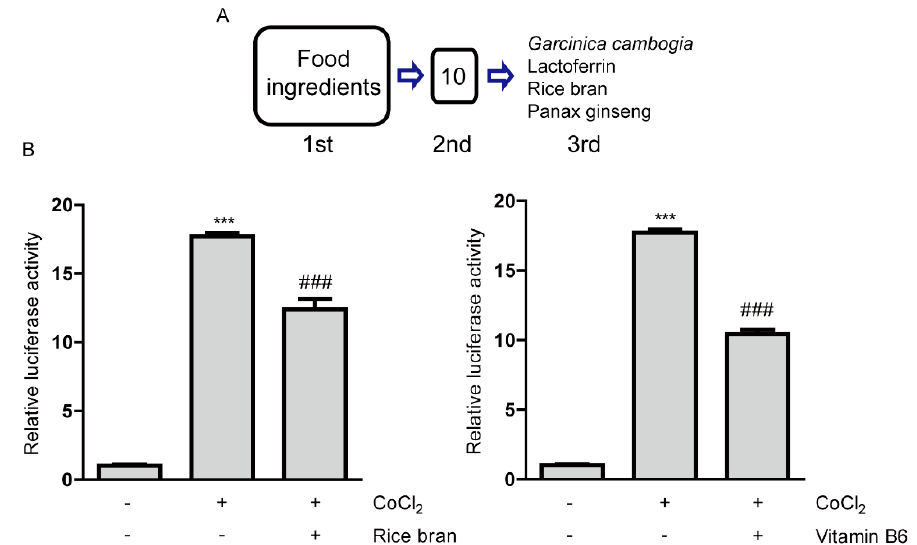
Figure 1. Inhibitory e ff ects of rice bran and vitamin B6 on hypoxia-inducible factor (HIF) activity. ( A ) A process of drug screenings for HIF inhibitors. After the first screening, 10 samples were shown to be positive. After the second screening, four food ingredients (lactoferrin, rice bran, panax ginseng and Garcinia cambogia ) with their expected 2 component compounds (hydroxycitric acid and vitamin B6) were selected as HIF inhibitors. ( B ) Quantitative analyses of HIF-reporter luciferase assay using ARPE-19 cells ( n = 3 per group) showed that rice bran (1 mg / mL) and vitamin B6 (1 mg / mL) inhibited HIF activity induced by 200 µ M CoCl 2 . *** p < 0.001, ### p < 0.001, compared with no treatment and 200 µ M of CoCl 2 treatment, respectively. Bar graphs were presented as mean with the ± standard deviation. The data were analyzed using one-way ANOVA followed by a Bonferroni post hoc test. Solvents, rice bran: DMSO; vitamin B6: water.